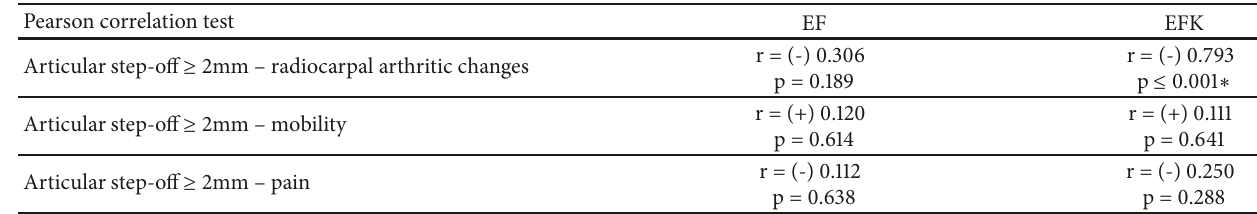
Table 4: Correlation of articular step-off to radiocarpal arthritic changes, mobility, and pain. Pearson correlation